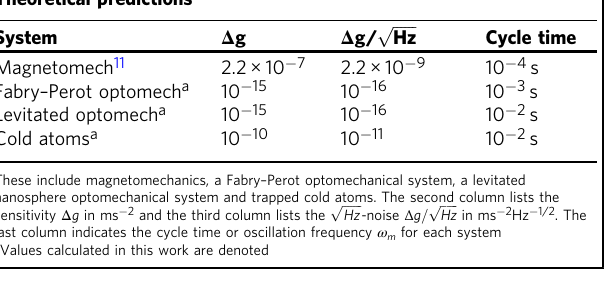
Table 2 Comparison between sensitivities obtained by theoretical predictions for a variety of systems Theoretical predictions